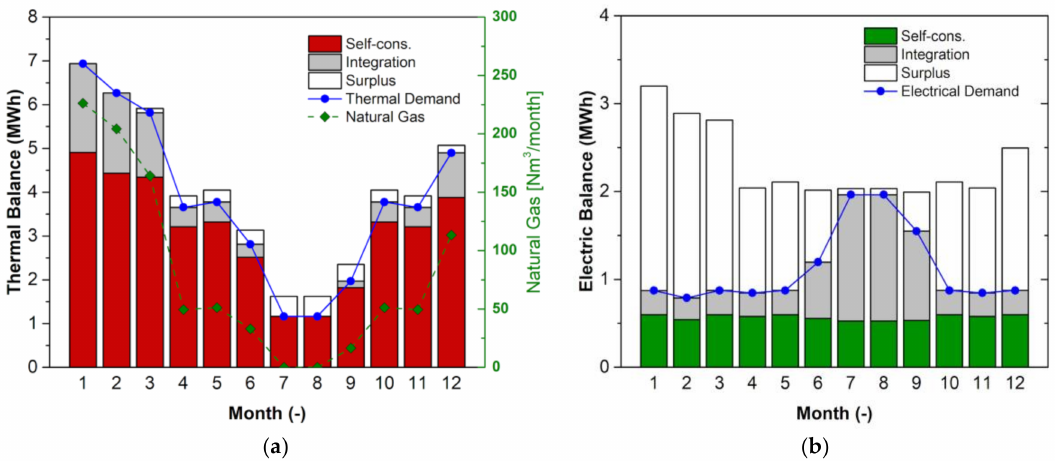
Figure 14. Monthly energy balances for the micro-CHP system with thermal-driven strategy and five apartments: ( a ) thermal balance; ( b ) electric